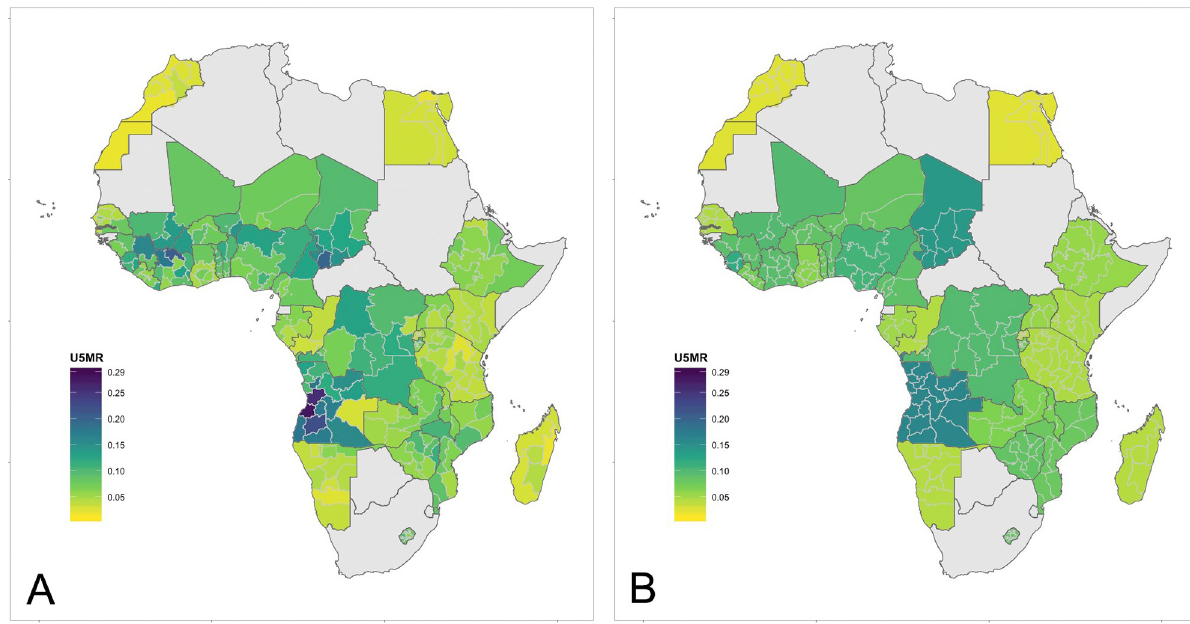
Fig 2. Projected U5MR in 2015. Green colors from 0 � 01 to 0 � 19. A: Projection using subnational model. B: Projection using national model.